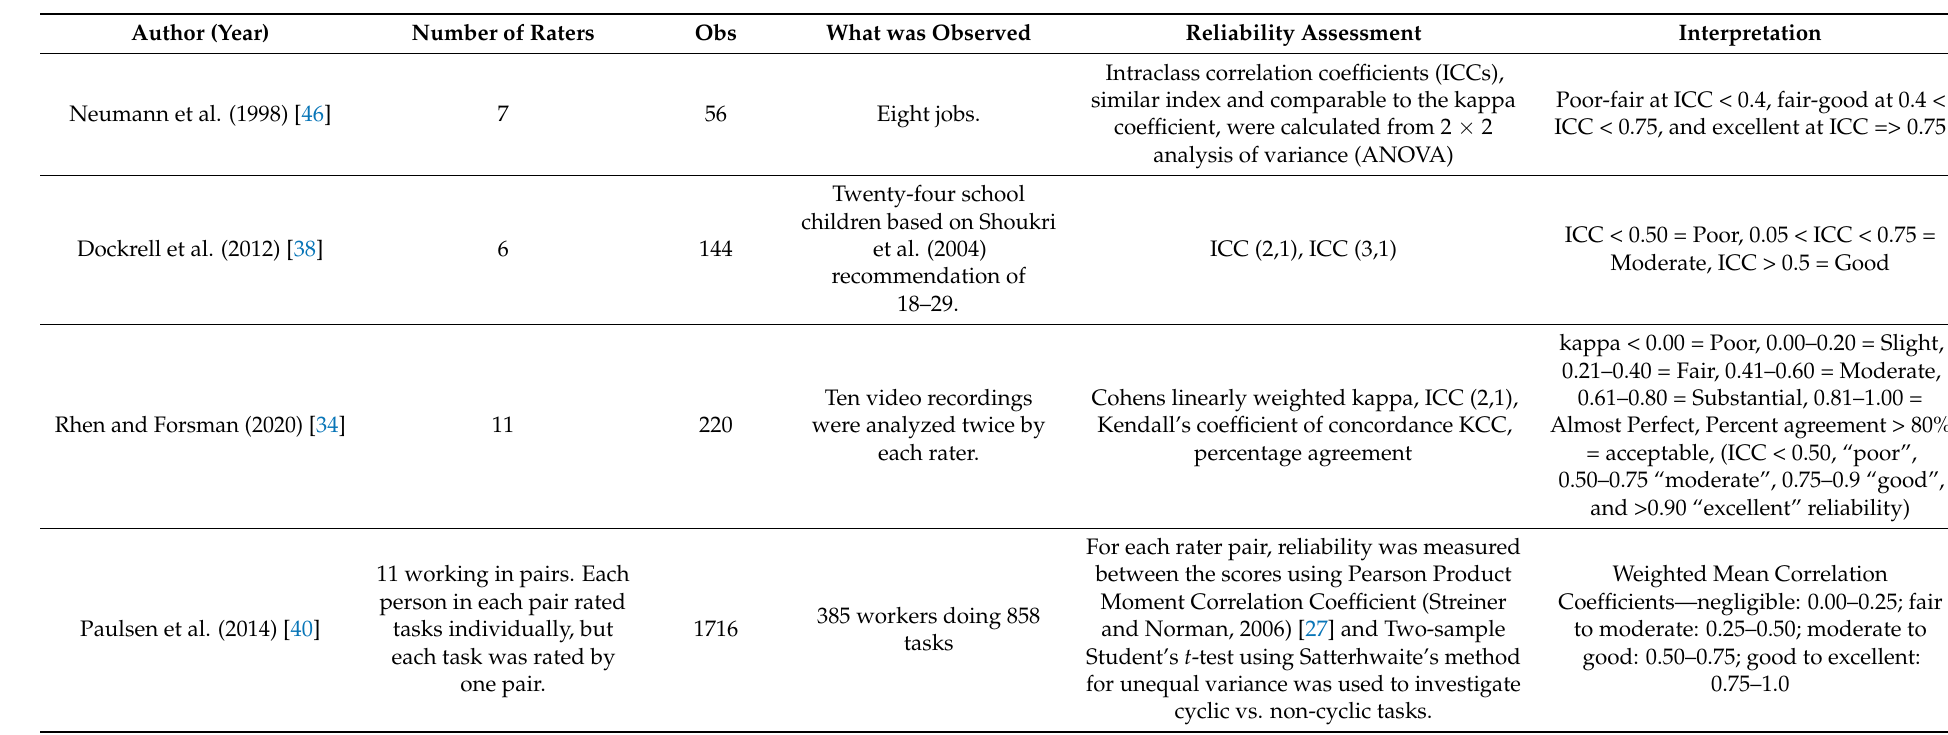
Table 3. Observation information, reliability assessment(s), and interpretation for the articles included in the review a